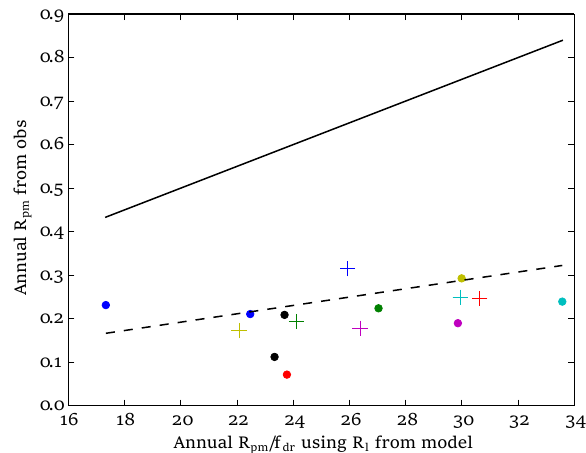
Figure 21. R pm derived from observed GPP against R pm /f dr de- rived from the outputted model leaf maintenance respiration. Dots and vertical crosses (+) are US-Ne1 and US-Ne2 respectively. JULES runs have the crop model switched off, LAI and canopy height prescribed and the input parameters in Tables 1, 2, 3, and 4. Black lines pass through the origin and have gradient 0.025 (solid line) and 0.0096 (dashed line), corresponding to the value of f dr used in Osborne et al. (2015) and this study